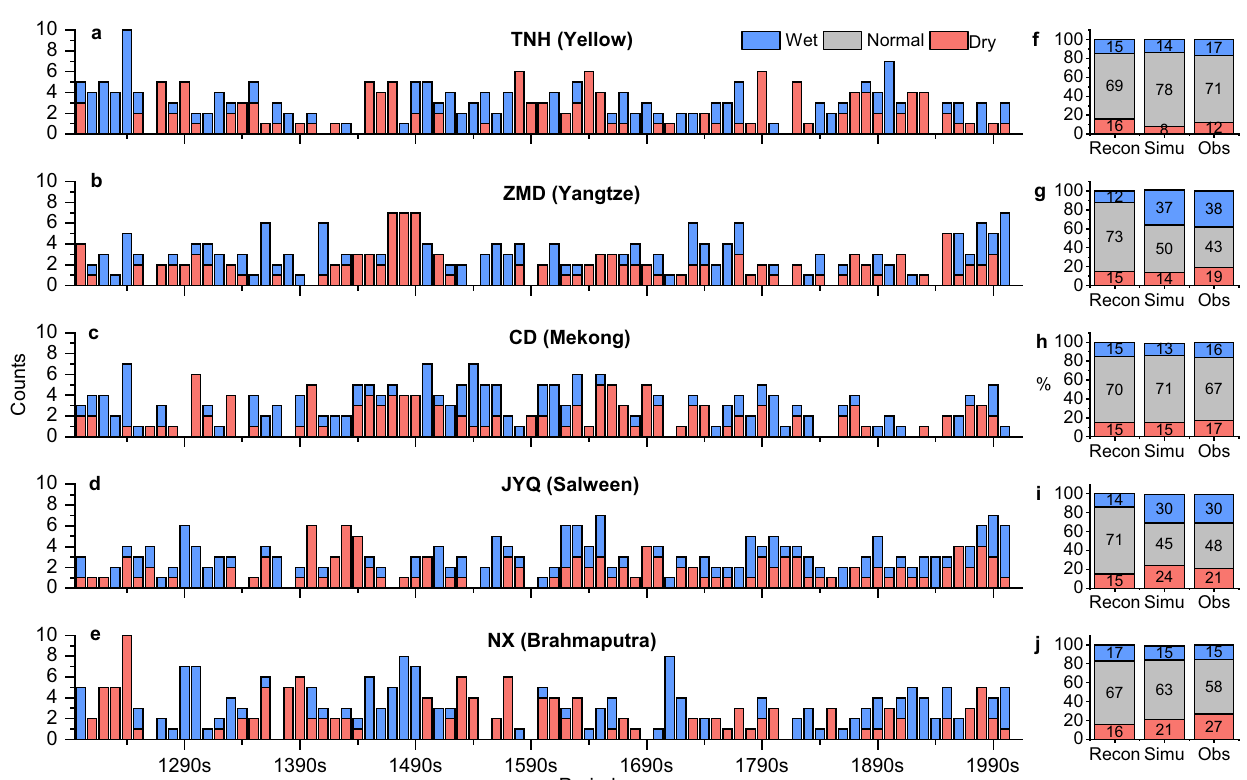
Fig. 5 | Numbers of extreme wet/dry years counted per decade and total per- centages of extreme years based on reconstructed and observed stream fl ow for the fi ve gauging stations. ( a and f ) Tangnaihai (TNH, Yellow); ( b and g ) Zhi- menda (ZMD, Yangtze); ( c and h ) Changdu (CD, Lancang-Mekong); ( d and i ) Jiayuqiao (JYQ, Nu-Salween); and ( e and j ) Nuxia (NX, Yarlung Zangbo-Brahmapu- tra).ForFig.5( f ) – ( j ),stackedbarplotsof ‘ Recon ’ representpercentagesofextreme